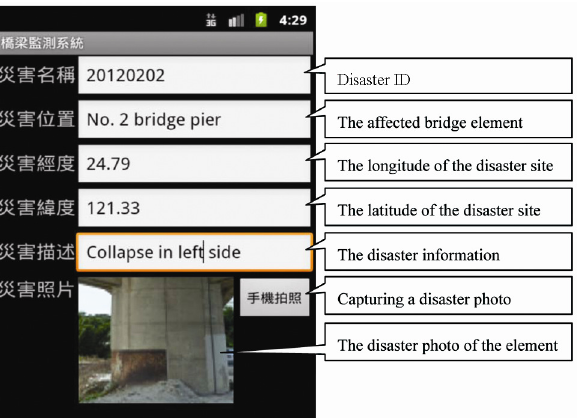
Fig. 5. A screenshot of mobile GPS- and GIS-based data reports